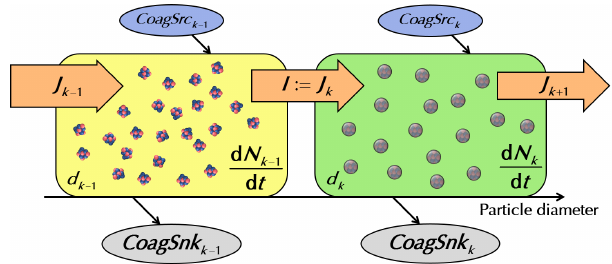
Figure 1. Schematic of the general dynamic